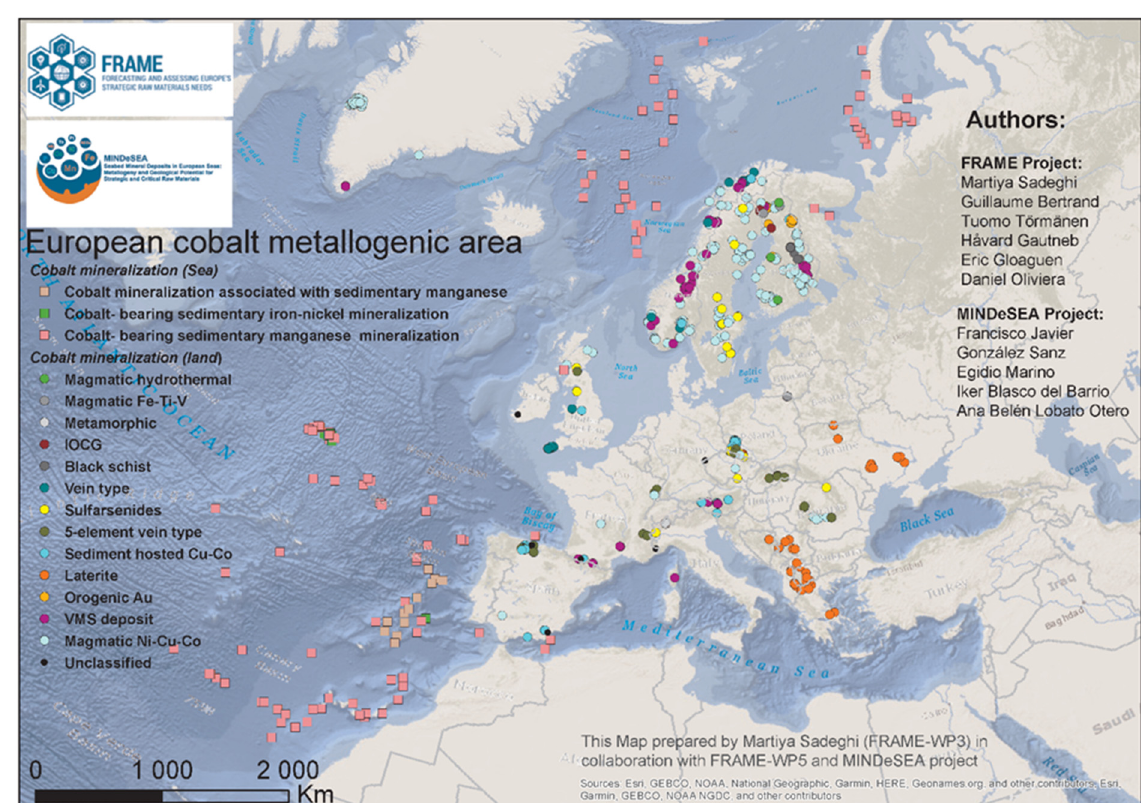
Figure 9. European cobalt metallogenic areas classified by style of mineralization, status October 2020, source: GeoERA scientific projects FRAME and MINDeSEA. GeoERA: Establishing the European Geological Surveys Research Area to deliver a Geological Service for Europe, FRAME: Forecasting And Assessing Europe’s Strategic Raw Materials Needs, MINDeSEA: Seabed Mineral Deposits in European Seas: Metallogeny and Geological Potential for Strategic and Critical Raw Materials. Reprinted from [13] Copyright From FRAME Project and MINSeSEA Project.